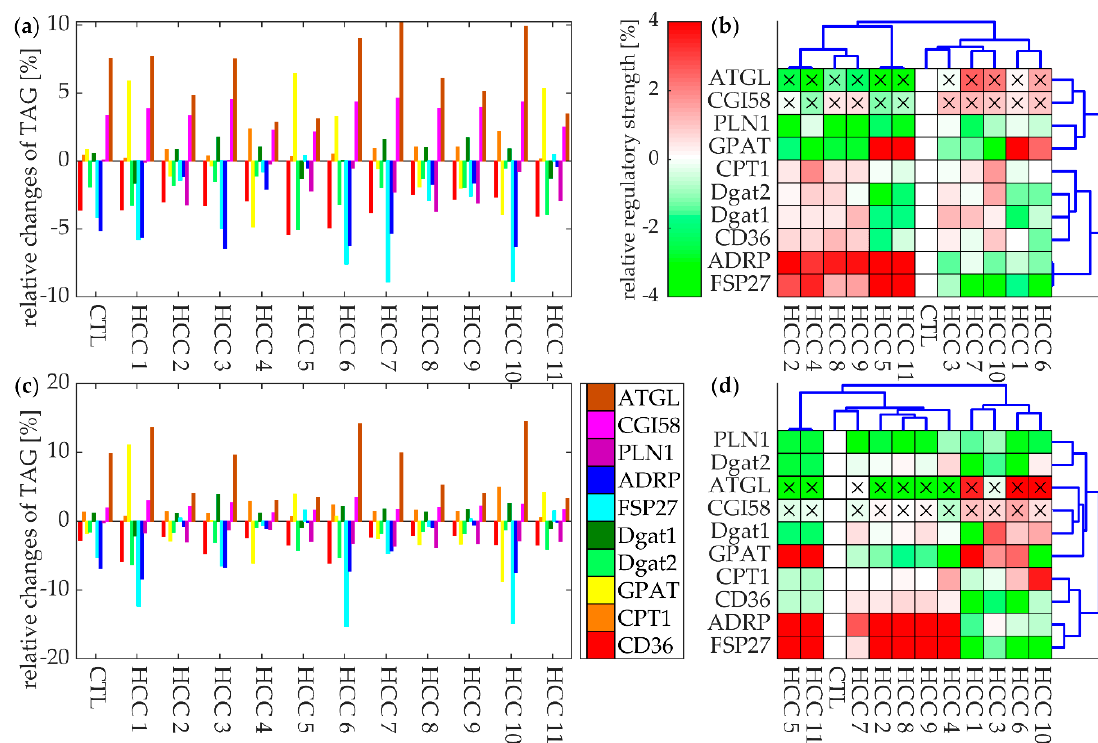
Figure 5. Regulatory impact of enzymes and RSPs on the TAG content. Panels in the upper or lower row show the results at normal or elevated plasma concentrations of FFAs, respectively. Clustering of tumors (x-axis) was performed according to similarities of their regulatory profiles, which are different under normal and elevated FFA plasma levels. Clustering of the regulatory proteins (y-axis) was performed according to similarities of the inhibition-induced TAG changes in different tumors. Boxes marked by an (x) depict the two proteins, where the enzymatic signature was set to unity due to completely missing protein intensity values. ( a , c ) Regulatory profiles of the ten most important regulatory proteins with Δ TAG > 6% in at least one tumor, ( b , d ) grouping of tumors according to the similarities of their regulatory profiles. Coloring indicates the size of the tumor-selective effect given by the difference Δ TAGtumor −Δ TAGcontrol.